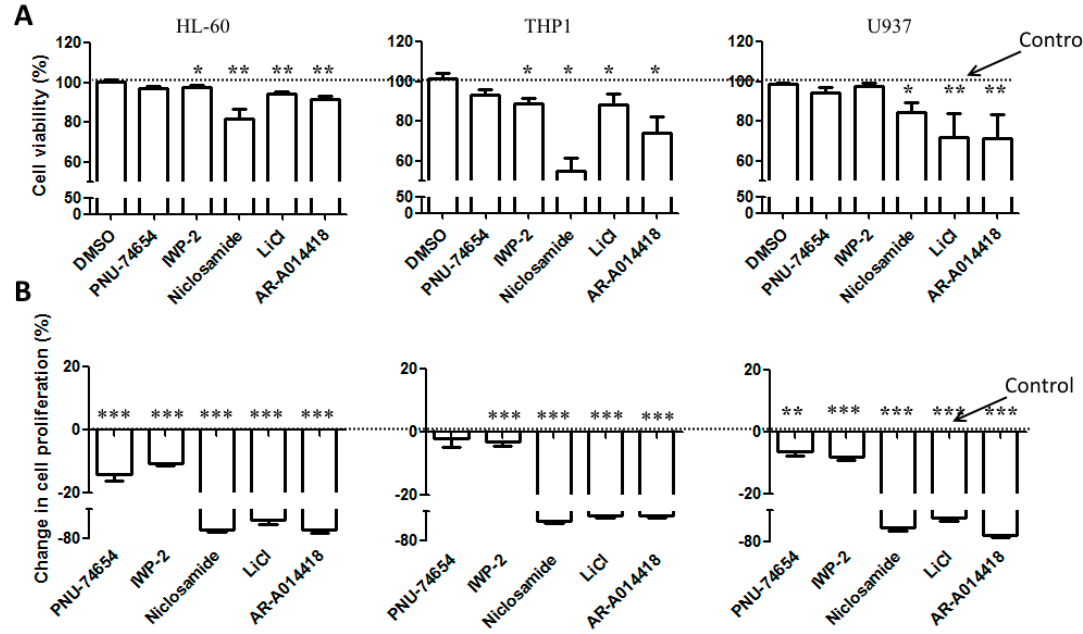
Figure 1. Cell viability and proliferation of AML cell lines cultured in the presence of Wnt and GSK-3 inhibitors. AML cells lines were stained with CFSE and cultured in the presence of either Wnt modulators, including PNU-74654 (15 µ M), IWP-2 (15 µ M) Niclosamide (1 µ M), or GSK-3 inhibitors, including LiCl (10 mM), AR-A014418 (15 µ M). After 4 days, cells were stained with TOPRO-3 to exclude dead cells. ( A ) Viable cells (TOPRO-3 negative cells) and CFSE-stained cells were quantified by FACS analysis. ( B ) Relative cell proliferation was expressed as the percentage of CFSE median fluorescence of treated cells compared to the cells treated with DMSO. Data are reported as mean ± SEM of 5 independent experiments. A Mann–Whitney test was used to analyze the di ff erences between means. * p < 0.05, ** p < 0.01, *** p < 0.001. Dot line: control.